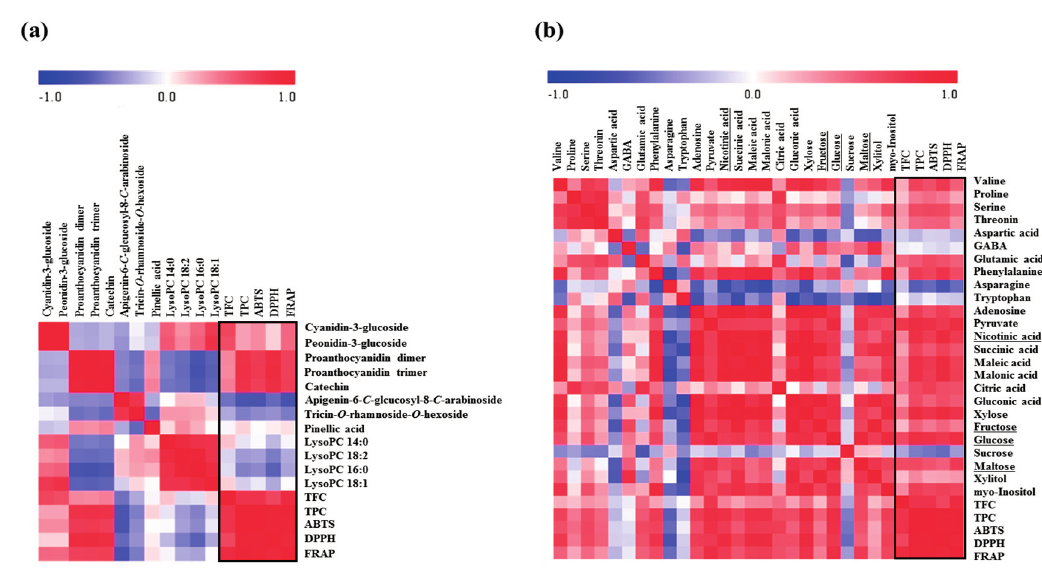
Figure 4. Correlation map of metabolites analyzed by UPLC-Q-TOF-MS and antioxidant activities ( a ) and correlation map of metabolites analyzed by GC-TOF-MS and antioxidant activities ( b ). Each square indicates r (Pearson’s correlation coefficient values for a pair of metabolites or antioxidant activities). The red color represents positive (0 < r < 1) correlation and blue color represents negative ( − 1 < r < 0)